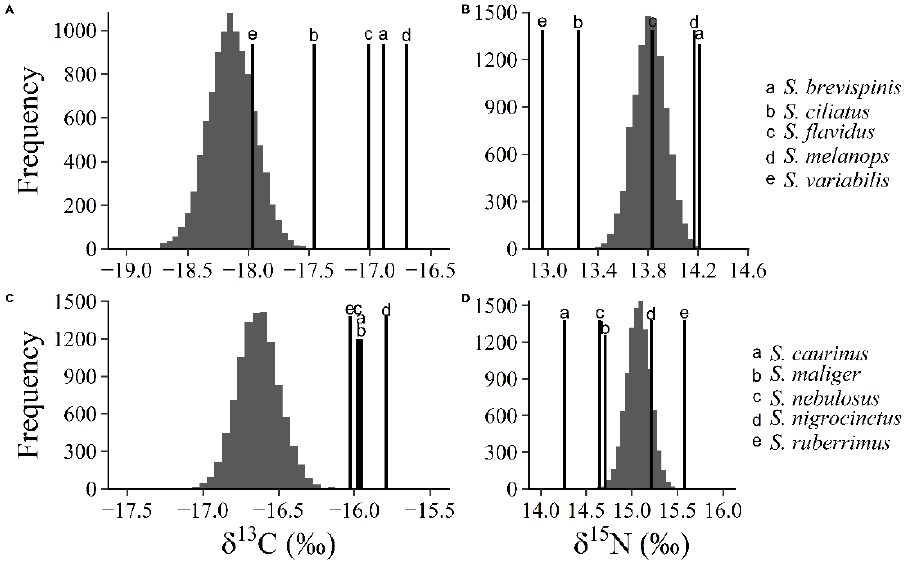
Figure 2. Comparison of observed trophic niche position and the null model distribution for pelagic and demersal rockfish. Each panel shows either the δ 13 C or δ 15 N null distributions based on the resampling of the isotopic values for pelagic ( A , B ) or demersal rockfish ( C , D ). Observed means for each rockfish species are represented by the bolded vertical lines.